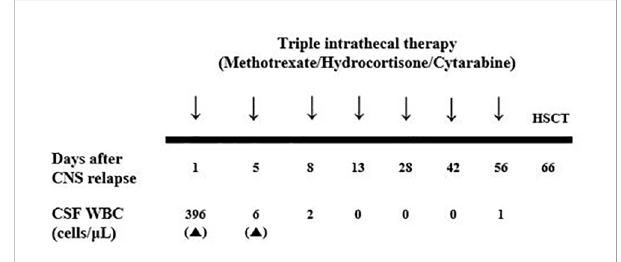
FIGURE 2 Schedule of triple intrathecal chemotherapy after CNS blast crisis and serial results of CSF WBC count. CNS, central nerve system; CSF, cerebrospinal fl uid; WBC, white blood cell.